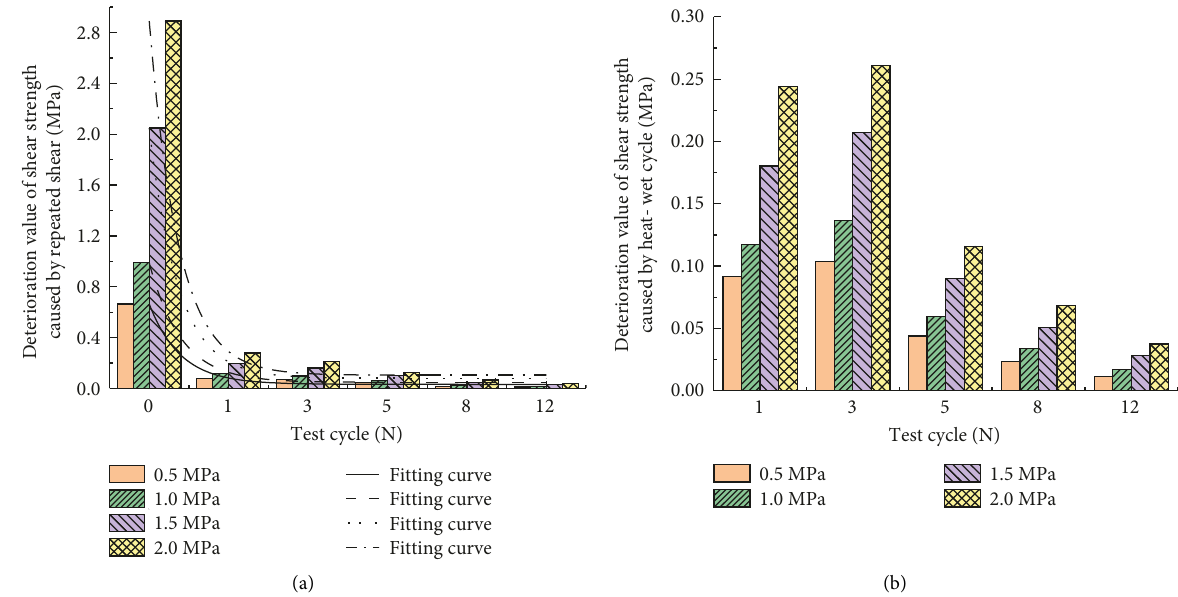
Figure 7: Deterioration value of shear strength caused by repeated shear and heat-wet cycles. (a) Deterioration value of shear strength caused by repeated shear. (b) Deterioration value of shear strength caused by heat-wet